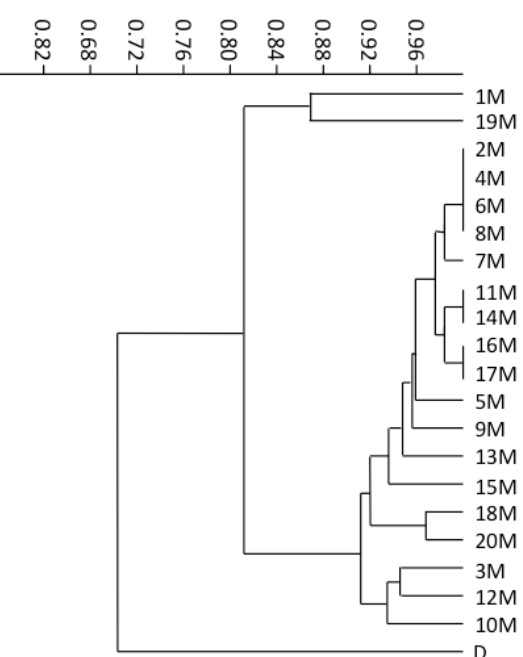
Figure 5. Dendrogram of 20 plants treated with the chemical mutagen EMS, evaluated by RAMP markers, using the nine combinations of primers. D: control.